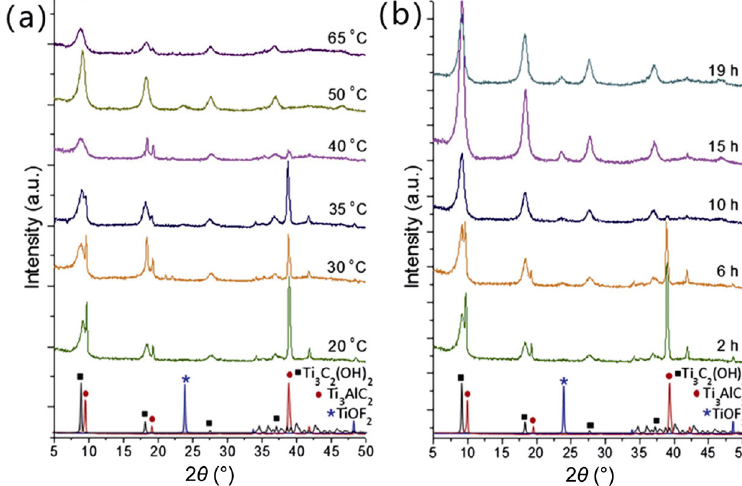
Fig. 11 XRD patterns of Ti 3 AlC 2 powders etched by 50% HF solution as a function of (a) the temperature after 2 h and (b) the time at room temperature. Reproduced with permission from Ref. [109], © Elsevier B.V.